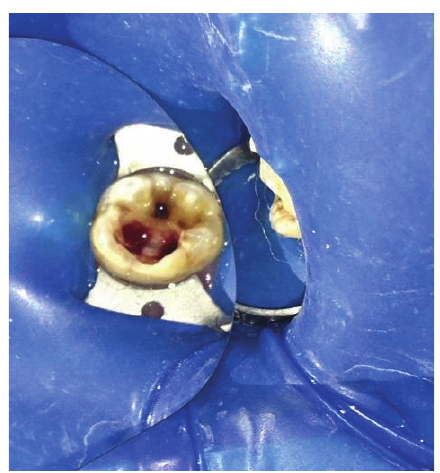
Figure 26: Access opening for pulpotomy procedure 36.